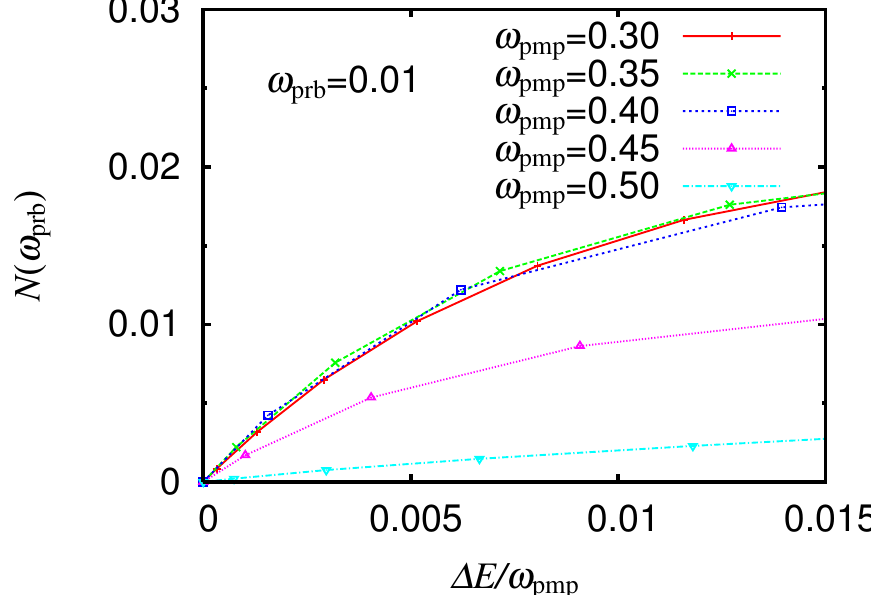
Figure 12. Increment in conductivity time-averaged and integrated over 0 < ω < ω N ( ω = 0 . 01) , as a function of the number of absorbed photons ∆ E/ω prb ω From [16]. Reproduced with permission from pmp